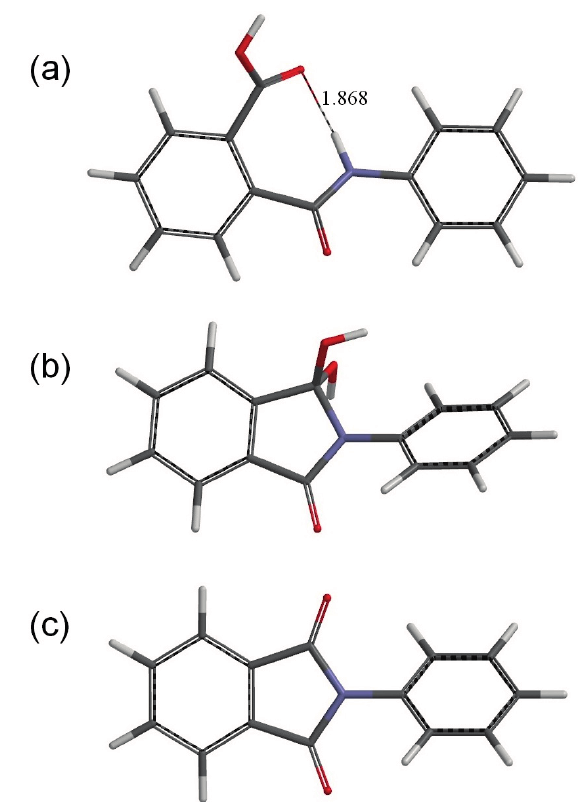
Figure 2. The geometries of ( a ) the reactant R (phthalanilic acid); ( b ) the gem -diol tetrahedral intermediate I; and ( c ) the N -phenylphthalimide product P. A hydrogen bond distance is shown in Å for R.